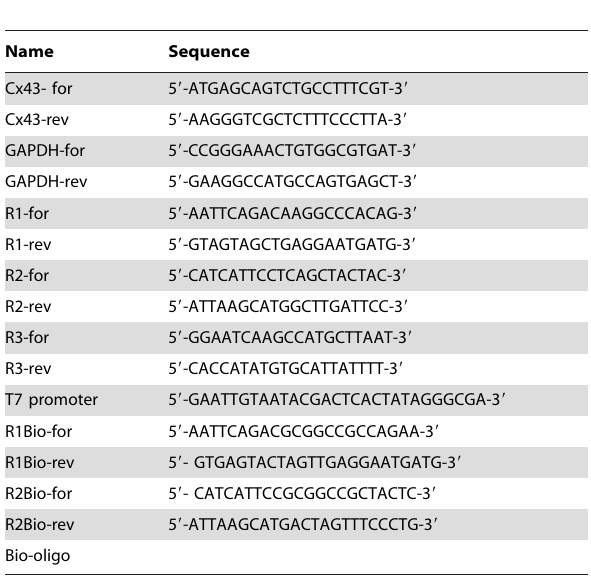
Table 2. List and sequences of the oligonucleotides used in this